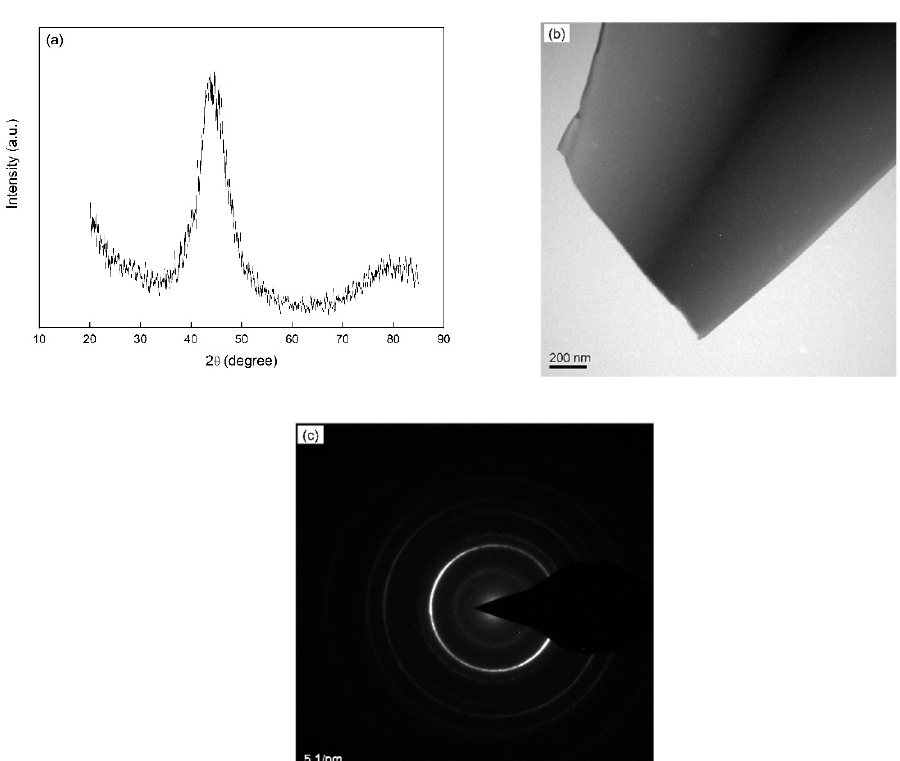
Figure 1. ( a ) X-ray diffraction pattern (Co-K α radiation), ( b ) TEM bright field image and ( c ) the corresponding selected area electron diffraction pattern (SAEDP) of the amorphous as-prepared Fe 85 B 15 alloy. The XRD and TEM investigations were carried out at room